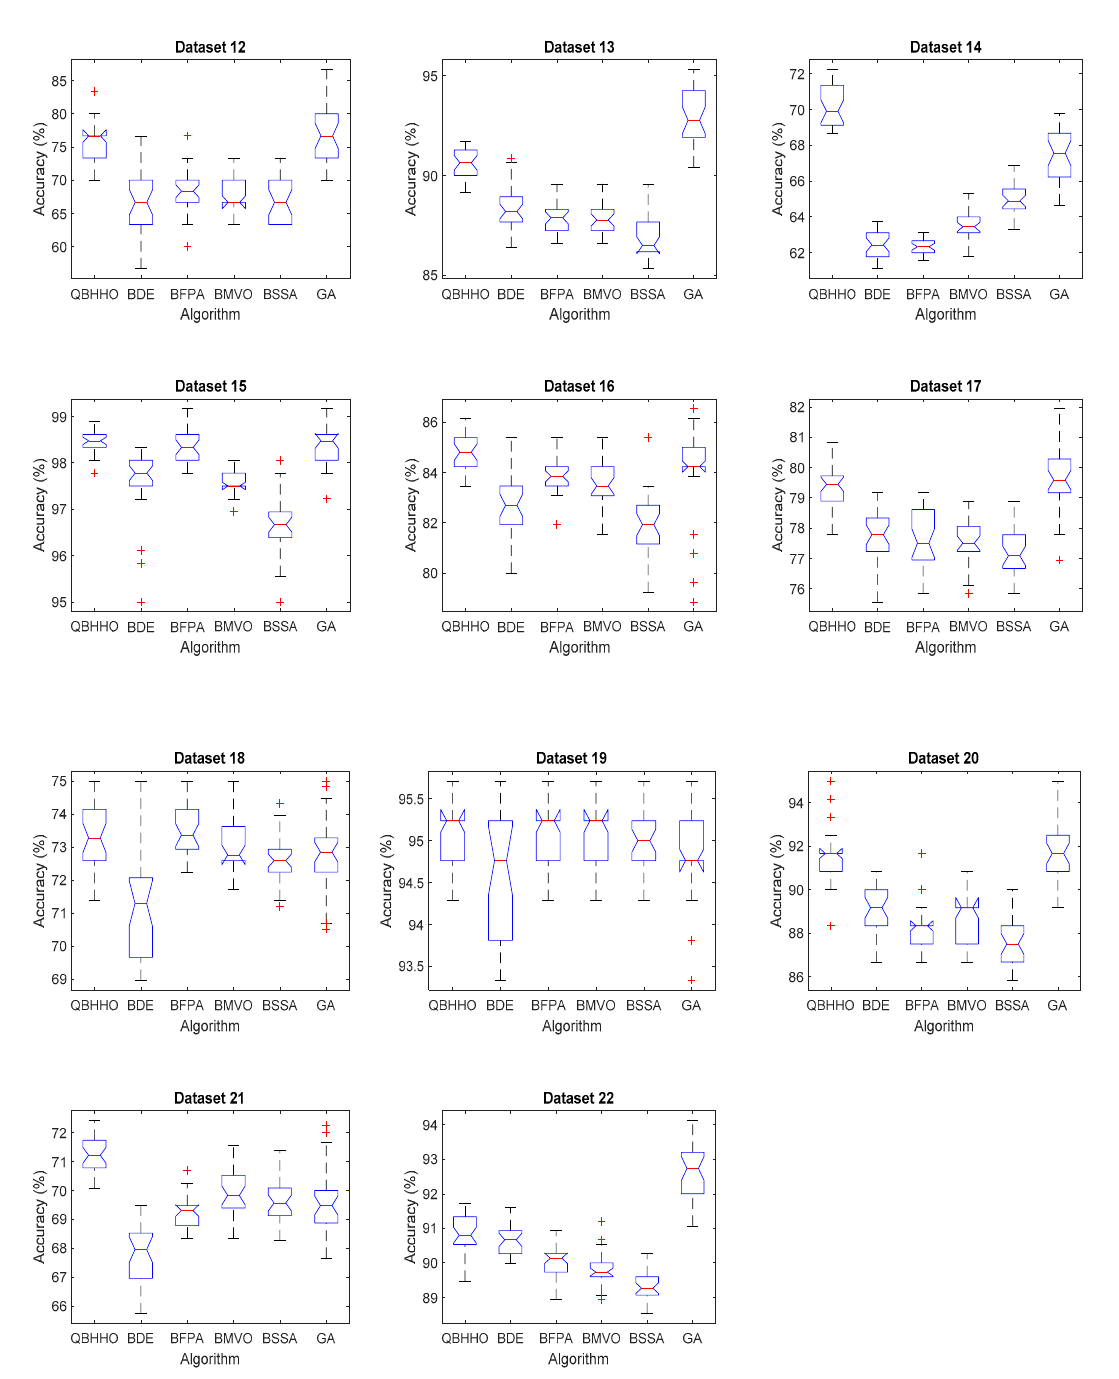
Figure 10. Boxplot of six di ff erent algorithms on datasets 12–22.